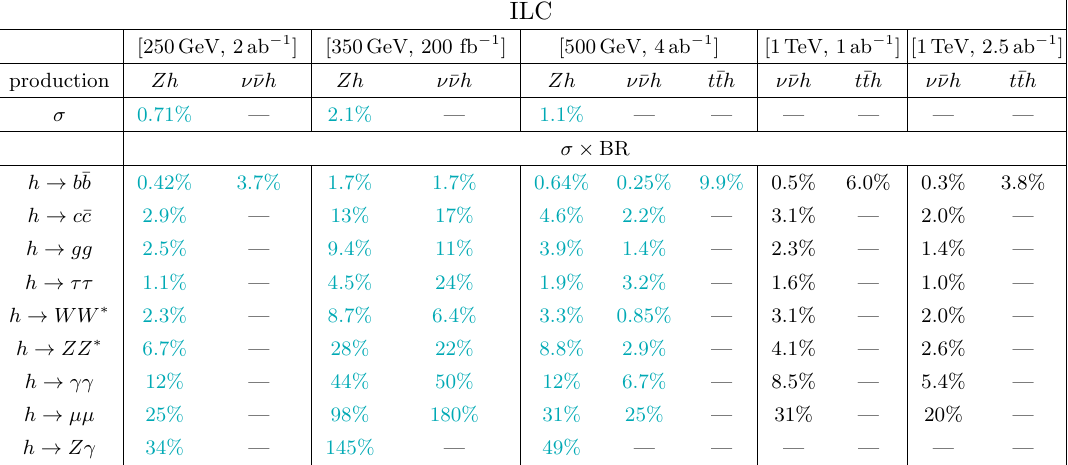
Table 3 . The estimated precision of ILC Higgs measurements. For the 250 GeV, 350 GeV and 500 GeV runs, all numbers are scaled from ref. [58] (table 13), except for (cid:27) ( hZ ) which is scaled from the CEPC estimation. A beam polarization of P ( e assumed. The 1 TeV run is only included in (cid:12)gure 17 of appendix C, while the estimations are taken from ref. [59] which assumes a polarization of P ( e